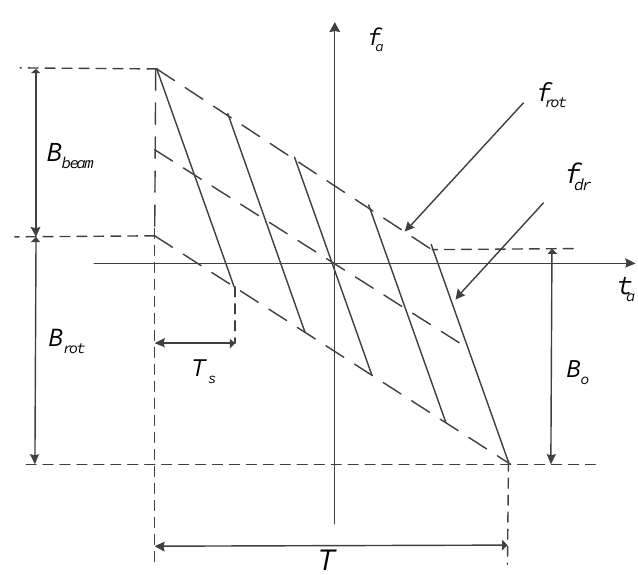
Figure 3. Doppler time-frequency relationship in the space-borne sliding-spotlight mode. B is the Doppler course of a single point, respectively. o